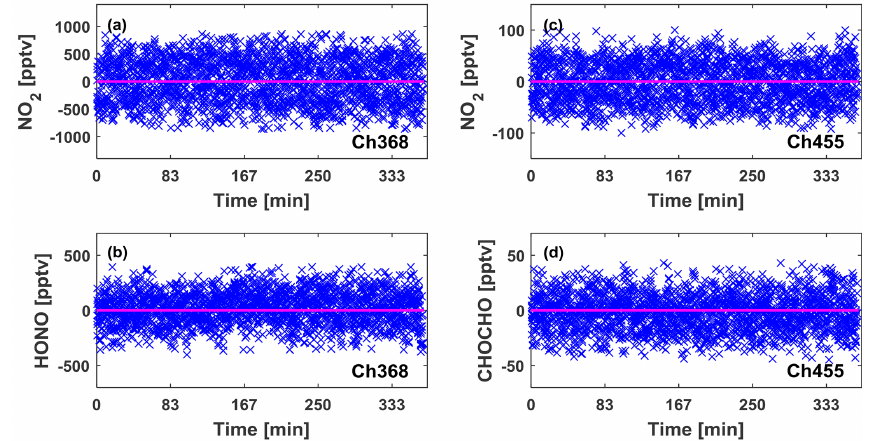
Figure 9. Spectral retrievals for Ch 368 (NO 2 and HONO; left panels) and Ch 455 (NO 2 and CHOCHO; right panels) for zero air measure- ments acquired during 8–14 June 2014 for CARE Beijing-NCP 2014. Each point represents a 10s average.